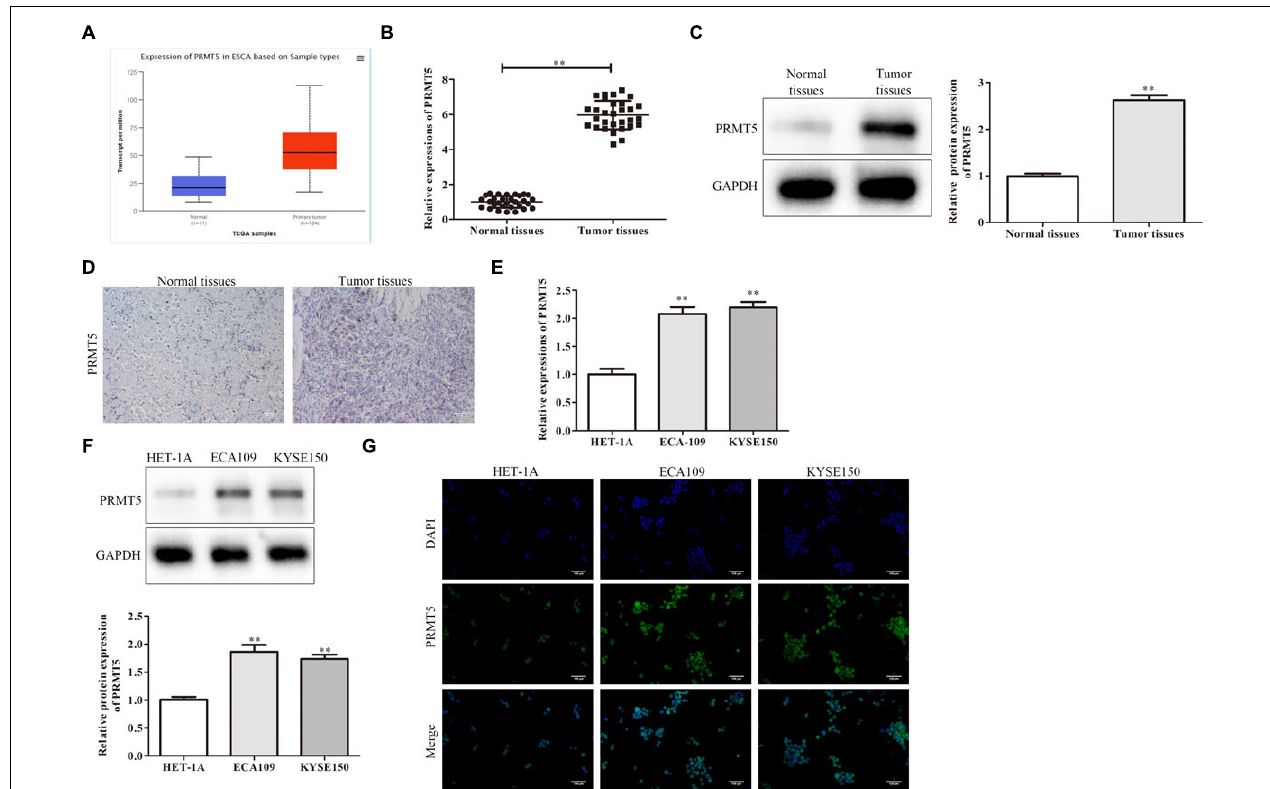
FIGURE 1 | PRMT5 was upregulated in ESCC tissues and cell lines. (A) The expression of PRMT5 was analyzed by using GEPIA database. (B) PRMT5 mRNA and protein expression in ESCC tissues and normal tissues were examined by RT-PCR assay. (C) PRMT5 mRNA and protein expression in ESCC tissues and normal tissues were examined by western blotting assay. (D) PRMT5 mRNA and protein expression in ESCC tissues and normal tissues were examined by immunohistochemistry assay. (E) PRMT5 expression in ESCC cell lines and human normal esophageal epithelial cell line was examined by RT-PCR assay. (F) PRMT5 expression in ESCC cell lines and human normal esophageal epithelial cell line was examined by western blotting assays. (G) PRMT5 expression in ESCC cell lines and human normal esophageal epithelial cell line was examined by immunofluorescence assays. Bars indicate the mean ± SEM, ** P < 0.01 vs. normal or HET-1A group. ESCC, esophageal squamous cell carcinoma; PRMT5, protein arginine methyltransferase 5; GEPIA, Gene Expression Profiling Interactive